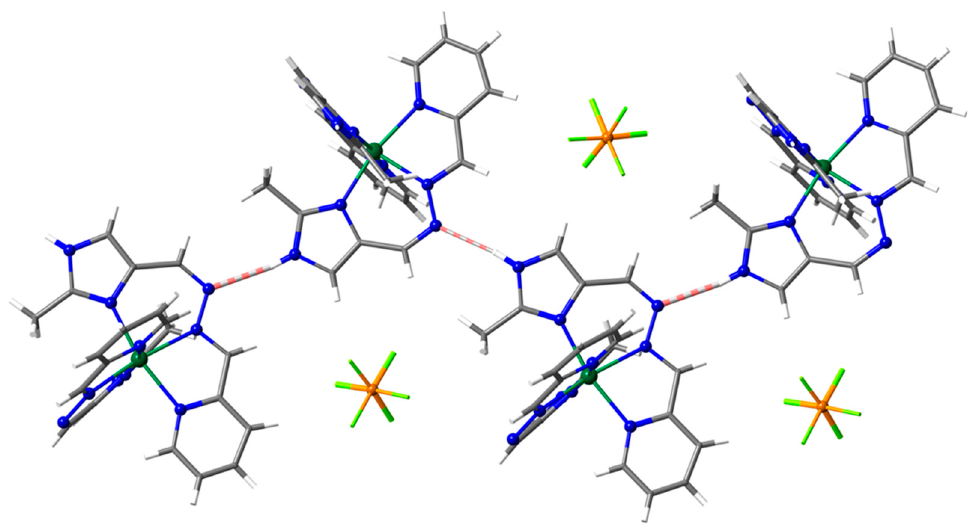
Figure 3. Intermolecular hydrogen-bonding interaction gives a one-dimensional polymer chain in 2 ·H 2 O·Et 2 O. Color code: Ni, teal; P orange; F, yellow-green; N, blue; C, gray; H, silver. 2 · H 2 O · Et 2 O. Color code: Ni, teal; P orange; F, yellow-green; N, blue; C, gray; H,